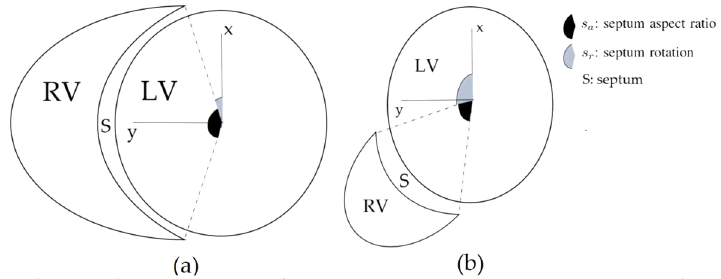
Figure 5. The planar shape of the RV relative to the LV for various septum aspect ratio s a and septum rotation s r values.